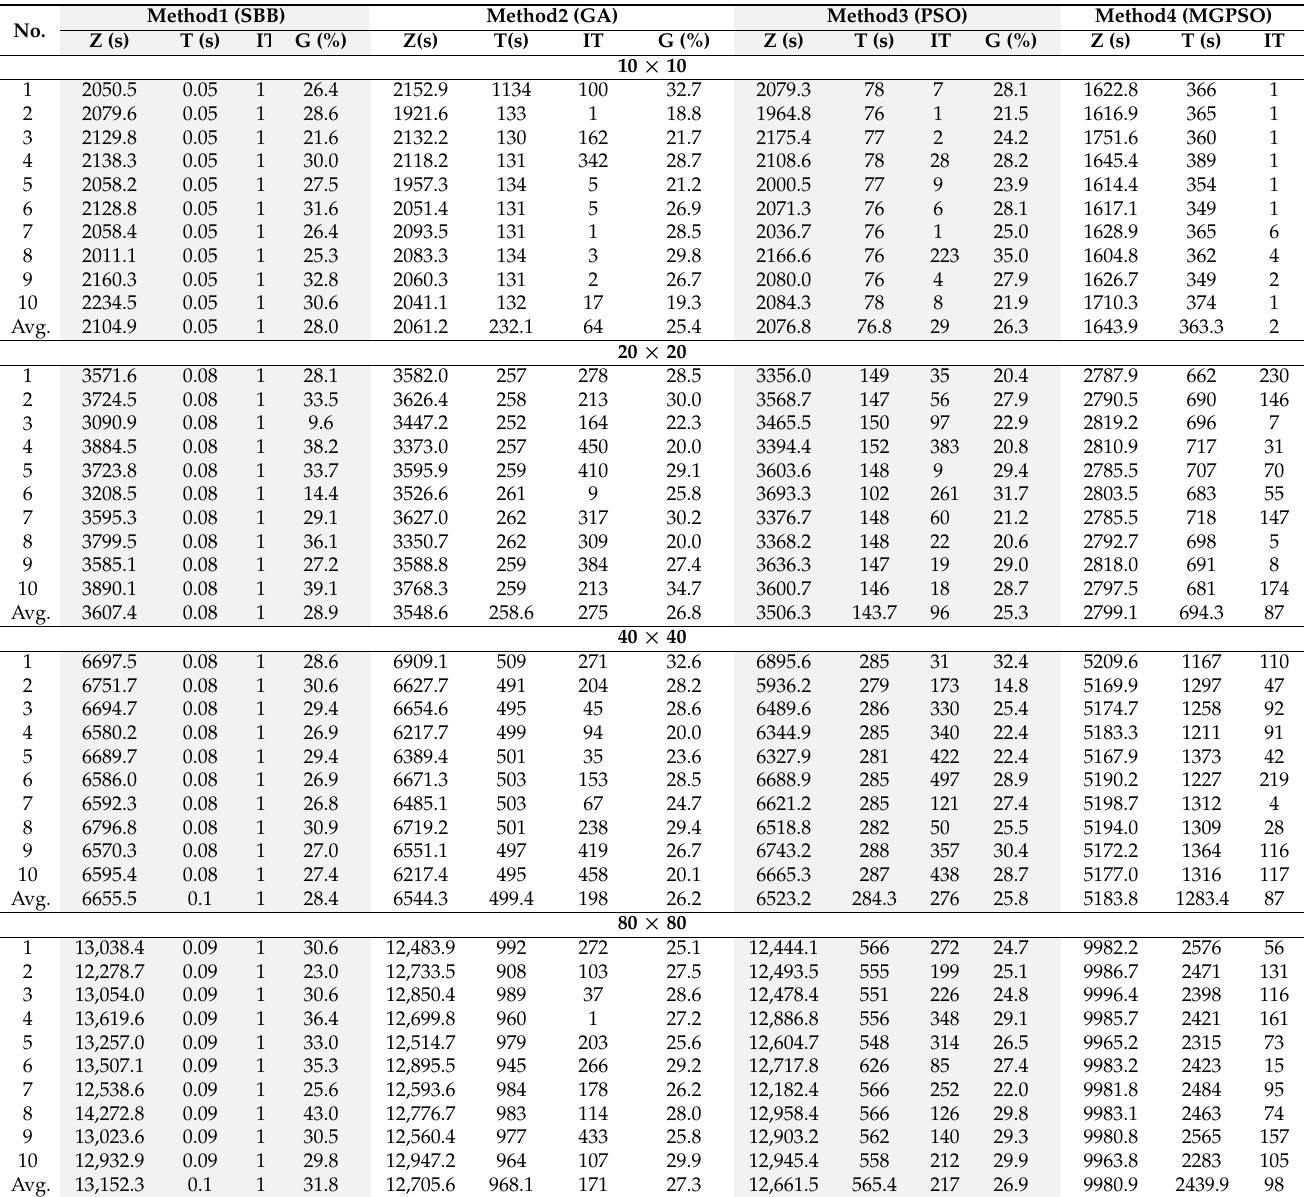
Table 8. The results obtained from different approaches under different problem